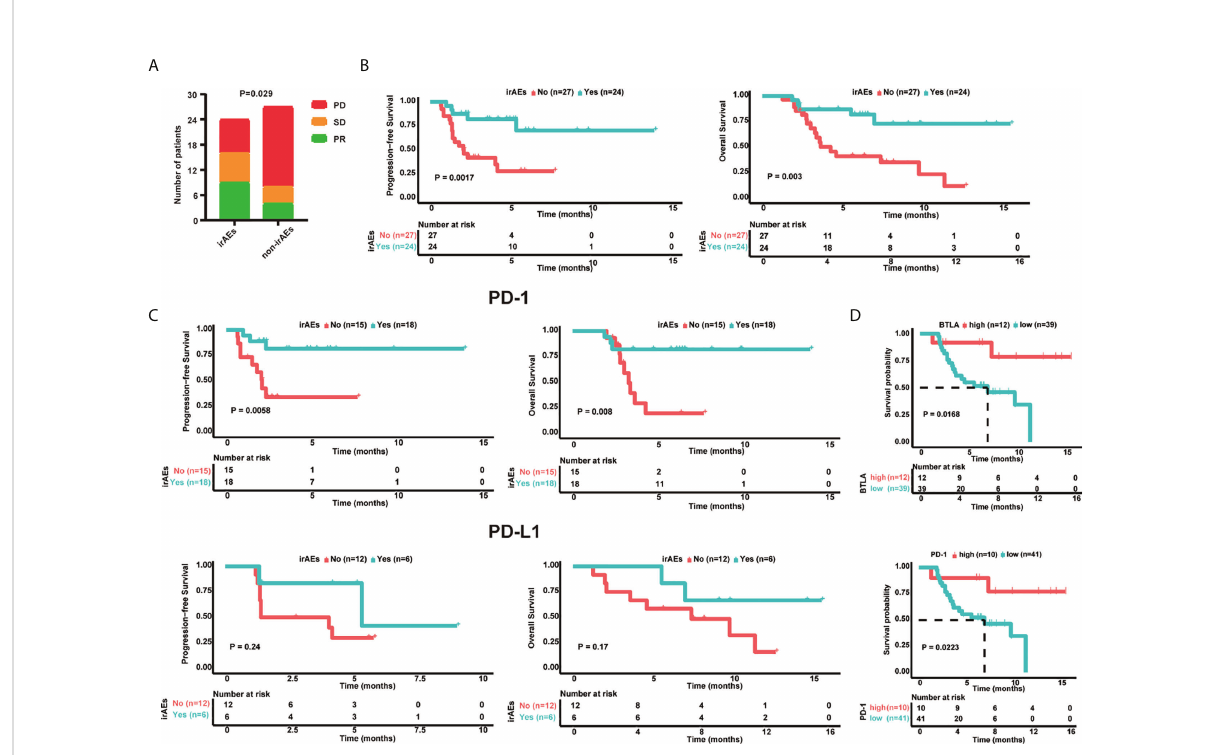
FIGURE 3 Baseline serum cytokine levels related to clinical outcomes. (A) Bar Chart showing the response rate in patients with (n = 24) and without irAEs (n = 27). (B) Kaplan-Meier survival curve of PFS and OS in the irAE (n = 24) and non-irAE (n = 27) groups. (C) Kaplan-Meier survival curve of progression-free survival (PFS) and overall survival (OS) following anti-PD-L1 (n = 18) and anti-PD-1 (n = 33) treatment in irAE and non-irAE groups. (D) OS of gastrointestinal cancer patients based on BTLA and PD-1 levels. CR: complete response, PR: partial response, SD: stable disease, PD: progressive disease, PFS: progression-free survival, OS: overall survival. Kaplan-Meier survival curves were plotted for patients using the median cutoff. Statistical signi fi cance was determined using the log ‐ rank (Mantel-Cox) regression analysis, with the level of signi fi cance at P ≤